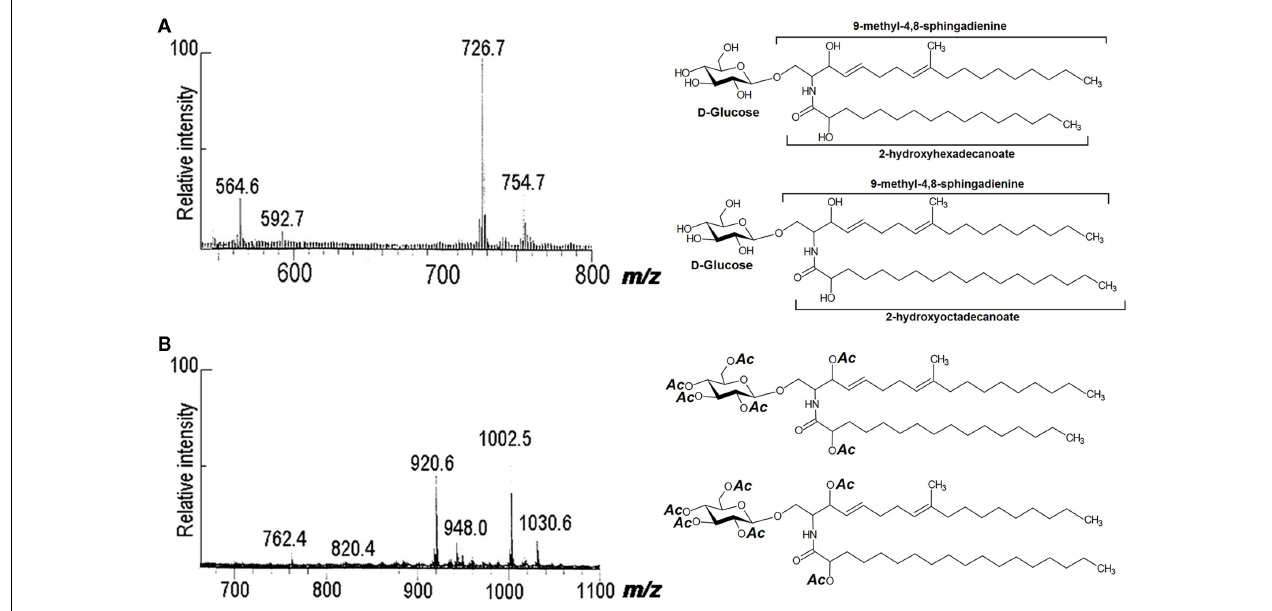
FIGURE 3 | Fast atom bombardment-mass spectrometry spectra of CMHs from P. boydii . (A) Negative-ion spectrum [M − H] − of native CMHs, and (B) positive-ion spectrum [M + Na] + of peracetylated CMHs.